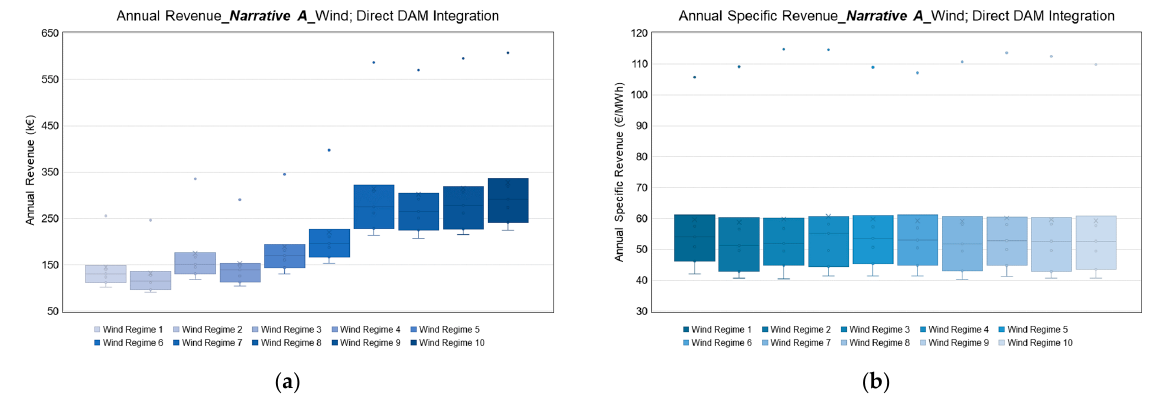
Figure 7. Direct market participation of the wind actor; annual ( a ) and specific ( b ) revenue per different wind regime, assuming no dispatchability constraints.